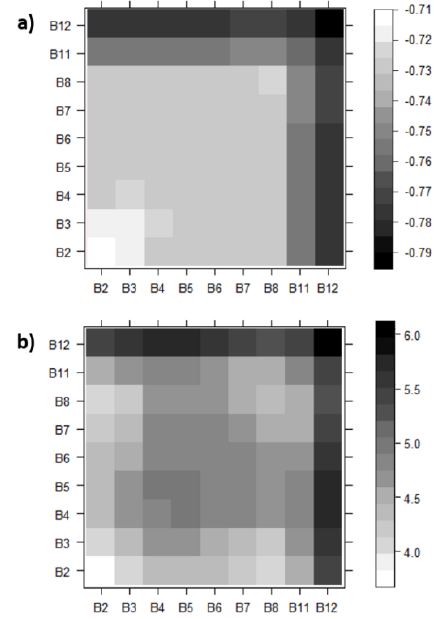
Figure 5. Pearson correlation coe ffi cient between SOC values of the calibration dataset and SOC indices ( a ) and the cross-validation ratio of performance to deviation (RPD) for the calibration models ( b ) obtained by the resampled LUCAS spectra, according to the MSI / Sentinel-2